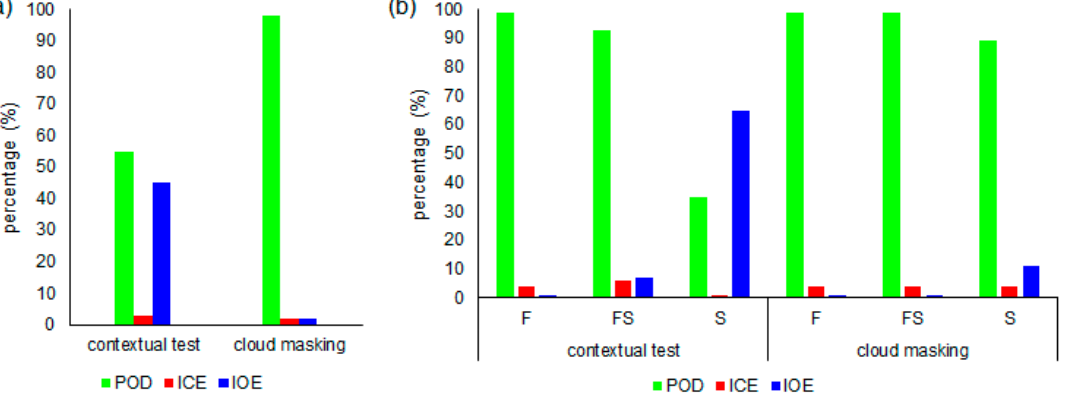
Figure 9. ( a ) Percentage of probability of detection (POD), independent commission errors (ICE) and independent omission errors (IOE) of ToPeCAl-2 with contextual test and ToPeCAl-2 with cloud masking applied to Landsat-8 OLI compared with fires resultant from ToPeCAl-1 applied to Landsat-8 OLI / TIRS images; ( b ) As per Figure ( a ) but showing the comparison of fire classes, i.e., flaming (F), smouldering (S), and mix of flaming and smouldering (FS).